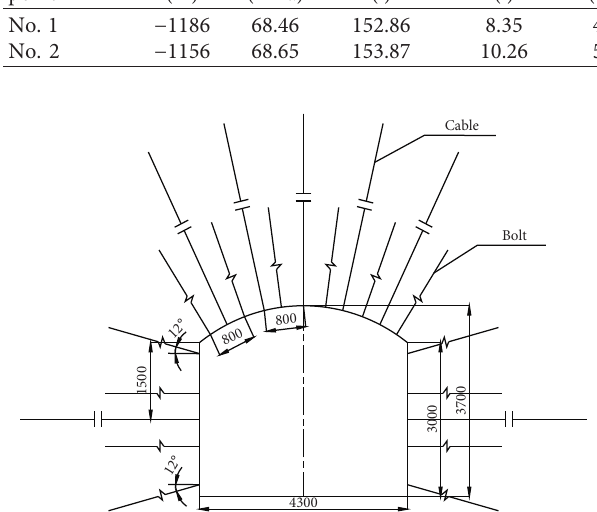
Figure 1: Section size and support parameters of No. 3 exploration roadway (unit: